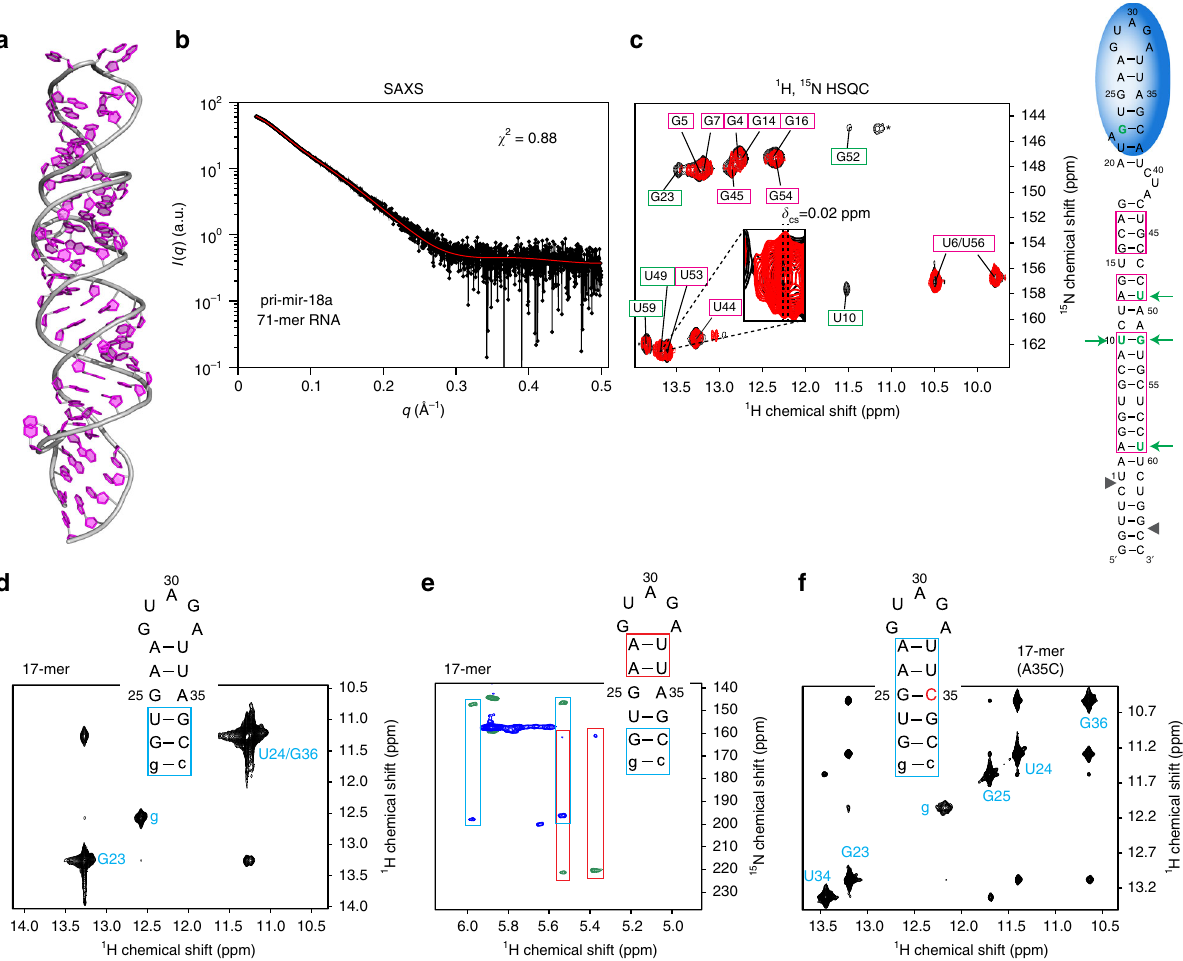
Fig. 4 Structural analysis of pri-mir-18a 71-mer RNA. a A structural model of pri-mir-18a 71-mer RNA obtained using the MC-Fold/MC-Sym server. b Experimental and predicted SAXS data for the pri-mir-18a model are shown in black and red, respectively. c NMR analysis of the 71-mer pri-mir-18a RNA. 1 H, 15 N-HSQC of 13 C, 15 N-labeled pri-mir-18a in the absence (black) and presence (red) of UP1. Imino signals observed indicating stable base-pairing are shown on the secondary structure of pri-mir-18a (magenta boxes). The signal marked with an asterisk has not been assigned. Nucleotides undergoing large perturbations and/or line broadening upon UP1 binding are highlighted with green boxes (left panel) or green letters and arrows (right panel). d 2D-imino NOESY and e H5 correlated HNN experiment of the 17-mer RNA derived from the terminal loop and fl anking stem of pri-mir-18a. Base pairs con fi rmed by these experiments are boxed in blue and red on the secondary structure of the 17-mer RNA. The fi rst G:C base pair, which is not part of the native sequence is shown in lower case. f 2D-imino NOESY of the 17-mer(A35C) RNA. The mutated nucleotide is shown in red. Base pairs con fi rmed by the detection of the imino correlation are